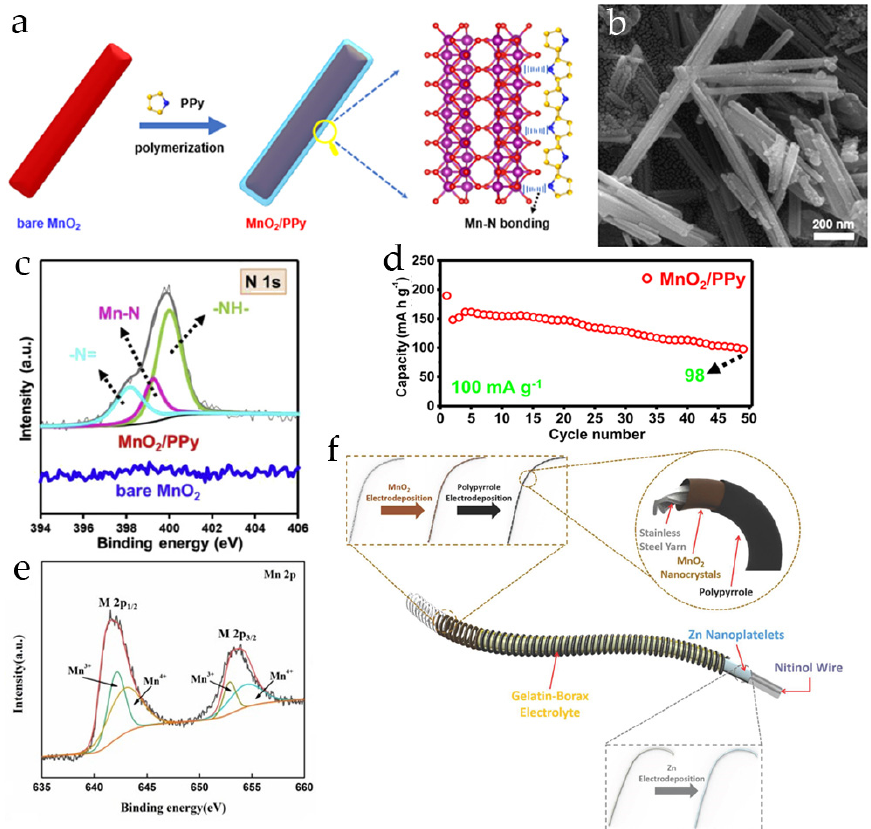
Figure 10 . ( a ) Schematic diagram of synthesis of MnO 2 /PPy composite [78]. ( b ) SEM image of MnO 2 /PPy nanorod [78]. ( c ) High-resolution N 1s XPS spectrum of MnO 2 /PPy composite [78]. ( d ) Continuous cycling performance of MnO 2 /PPy electrode in 2 M ZnSO 4 aqueous electrolyte [78]. ( e ) High-resolution Mn 2p and N 1s XPS spectra of α -MnO 2 /rGO-PPy composite [82]. ( f ) The construction of the flexible Zn//MnO 2 device with shape memory function [85].